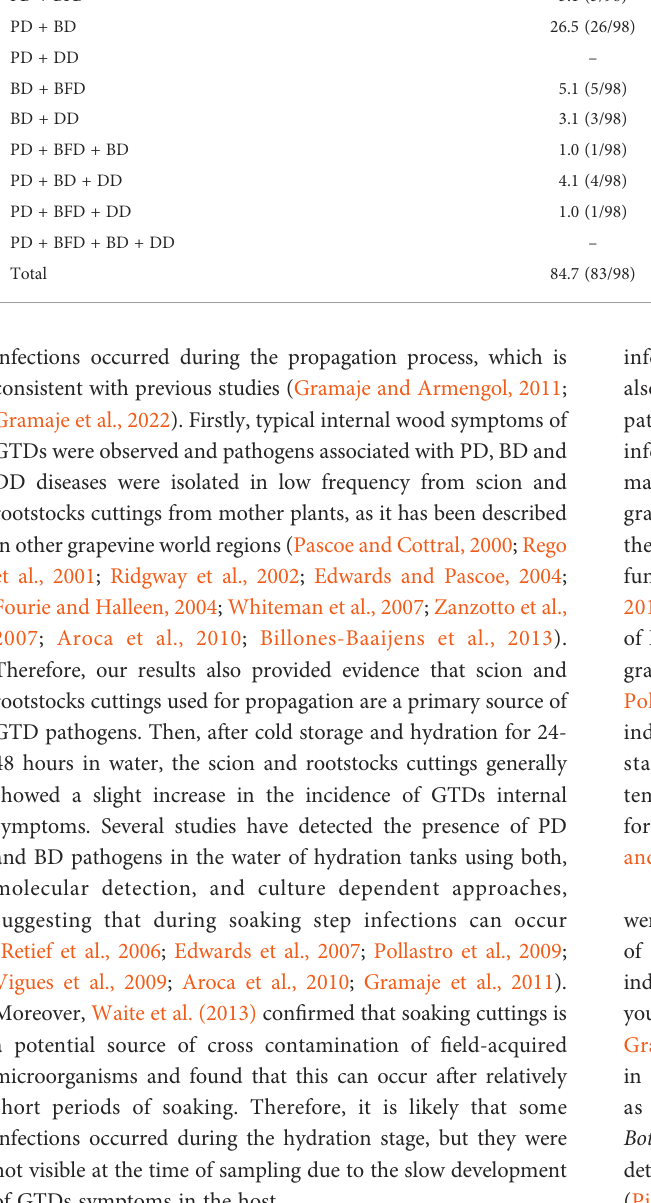
TABLE 4 Incidence of grapevine trunk diseases on grafted rooted vines ready to plant (stage 4) based on fungal isolations . Fungal